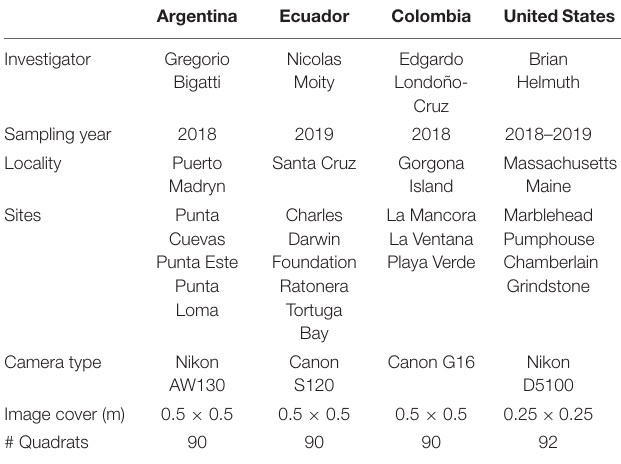
TABLE 1 | Summary of sampling